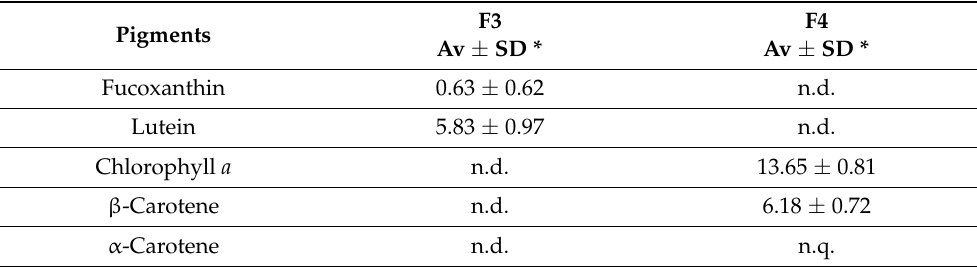
Table 4. The pigment composition of A. rigida determined by